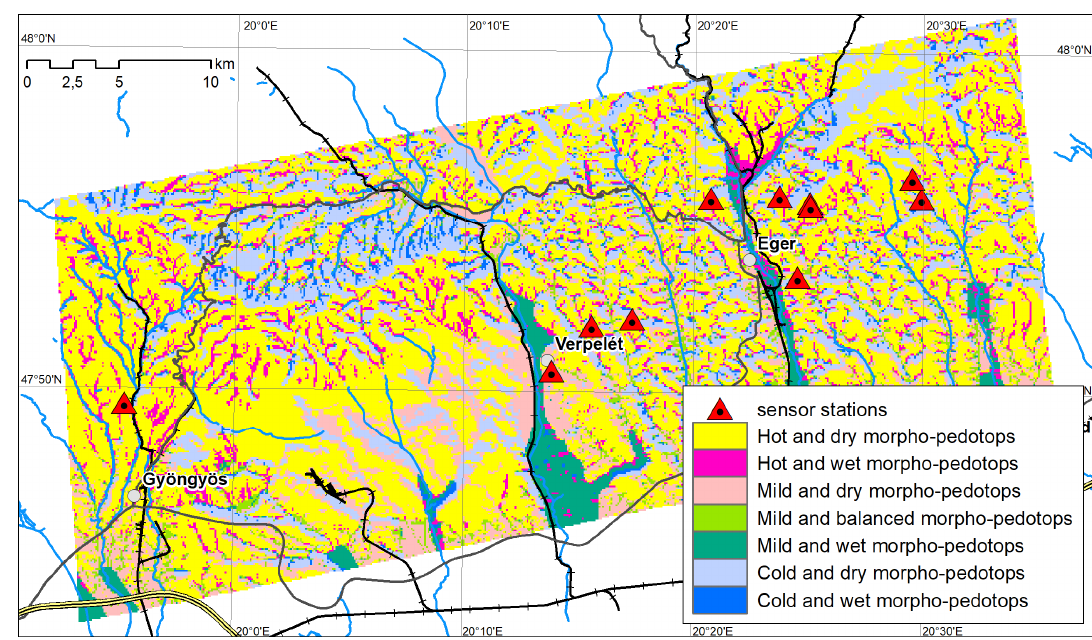
Figure 7. Different combinations of morpho-pedotop thermal and moisture regimes.